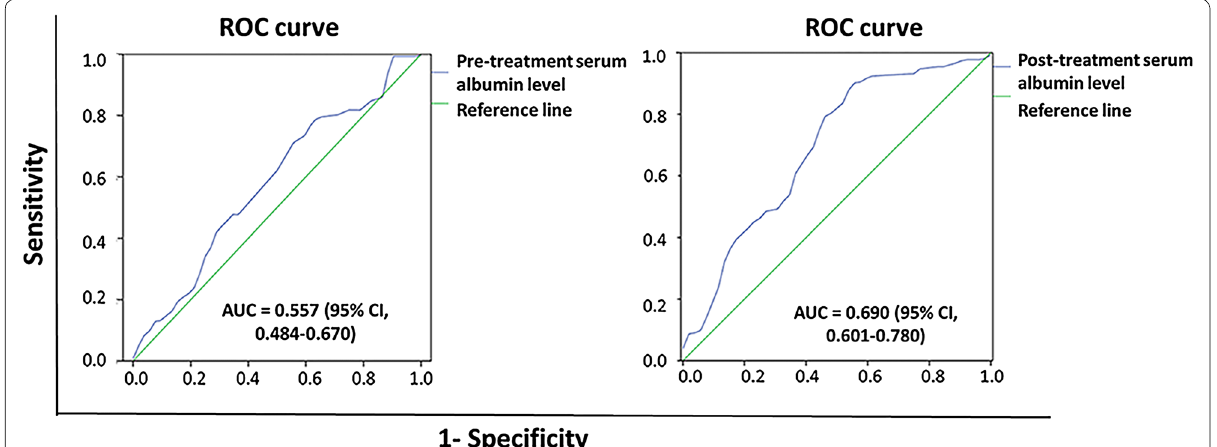
Fig. 1 Receiver operating characteristic (ROC) analysis to predict the cutoff levels of pre-treatment and post-treatment serum albumin levels. AUC, area under the curve; CI, confidence interval